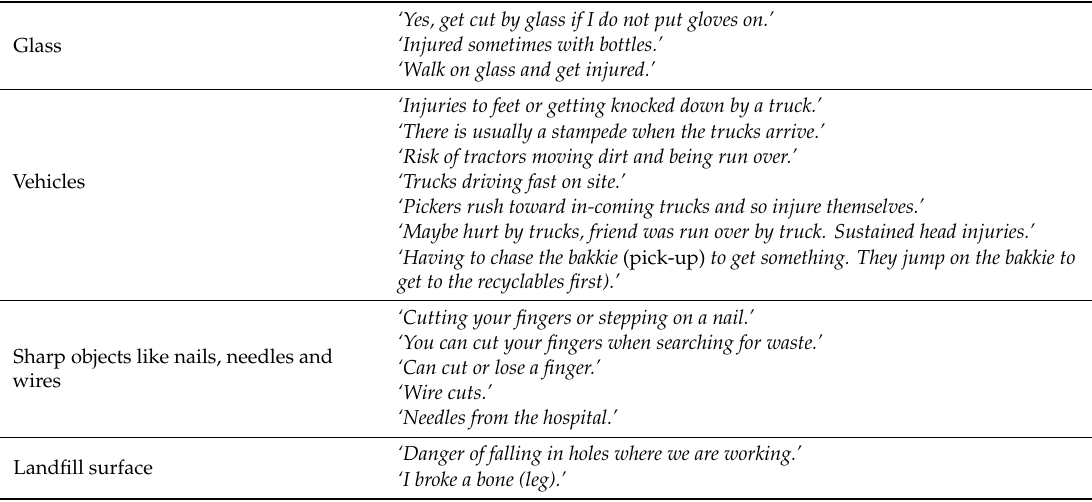
Table 7. Risks to which waste pickers are exposed.